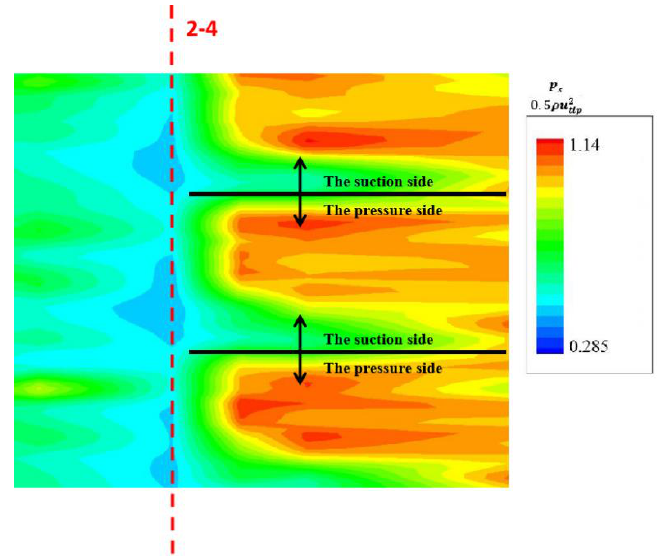
Figure 7. The distribution of the pressure coefficient inside Figure 7 . The distribution of the pressure coefficient inside R2 .